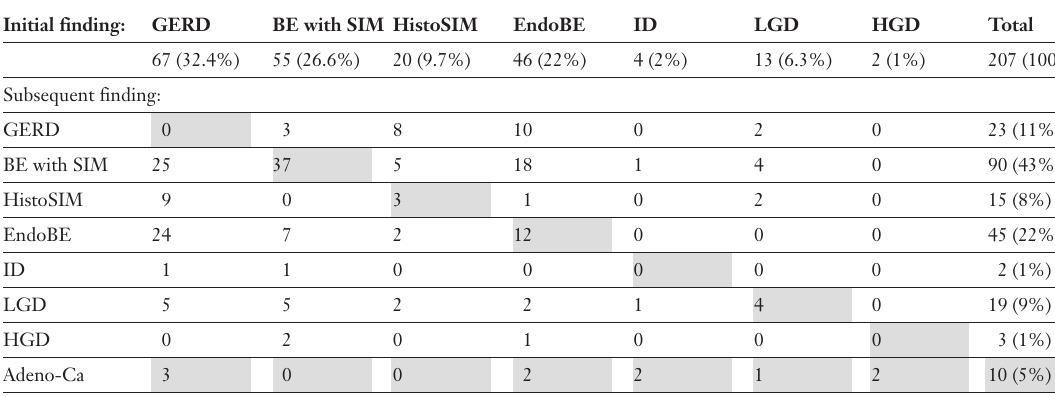
Progression of histological findings during follow-up (group B): reviewed and reclassified data